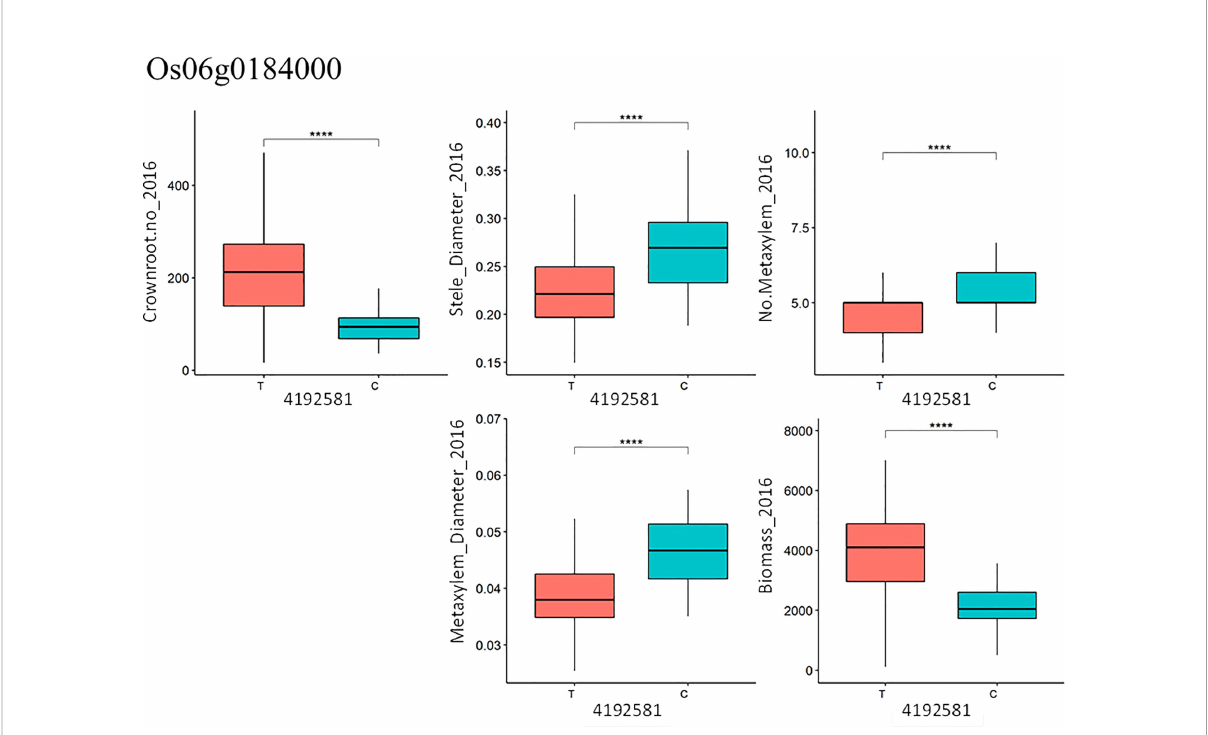
FIGURE 7 Functional SNPs at position 4192581 with T/C allele in gene Os06g0184000 ( OsRHL1 ) for total crown root number (Crownroot.no_2016) and association with other phenotypes. **** denotes P<0.0001 based on t-test with Bonferroni